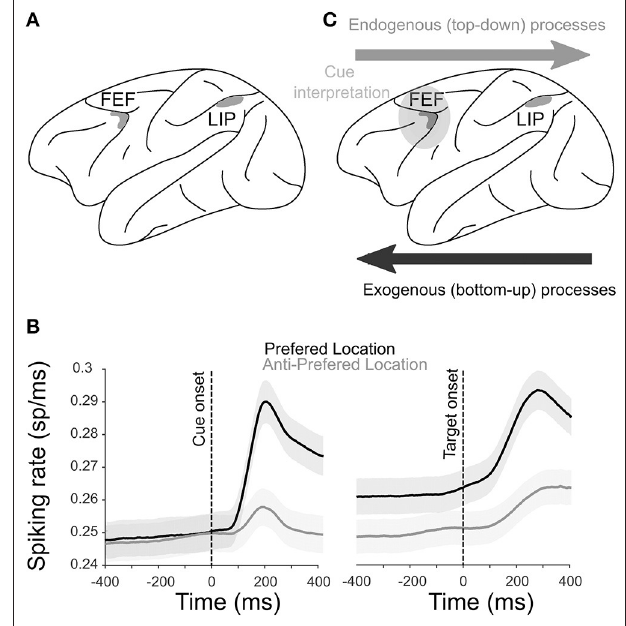
FIGURE 1 | Physiology of the attentional system. (A) Anatomical localization of the two core brain regions engaged during spatial attention orienting in the macaque [shaded in gray; see Cohen and Andersen (2002), Ibos et al. (2013), Paneri and Gregoriou (2017), for a review], the FEF and the LIP sulcus. (B) The average multiunit activity (MUA; ± s.e.) recorded from the FEF in one monkey when a cue is orienting attention toward the preferred (black) or the anti-preferred (gray) spatial location locked to cue (left) and target (right) onsets. X -axis represents the time around cue or target onsets. (C) Functional hierarchy in a frontoparietal network during attentional processes. Exogenous processes start in the LIP and project to the FEF. Cue interpretation takes place in the FEF, and the selection of the spatial location and subsequent endogenous processing is projected from the FEF to the LIP.